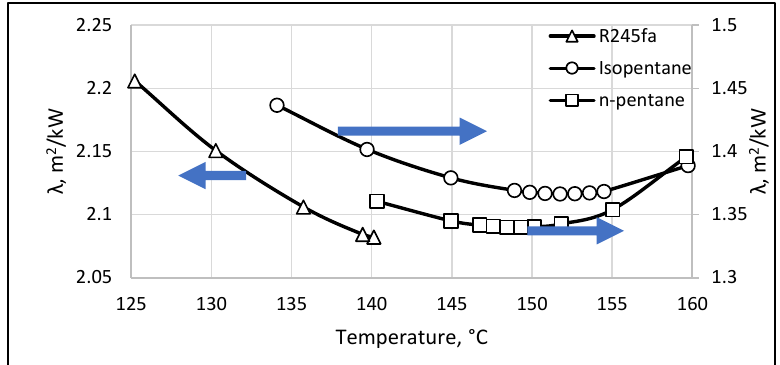
Figure 4. Thermal efficiency optimization results with varied temperature and pressure for ( a ) n- Pentane; ( b ) Isopentane; ( c ) R245fa.